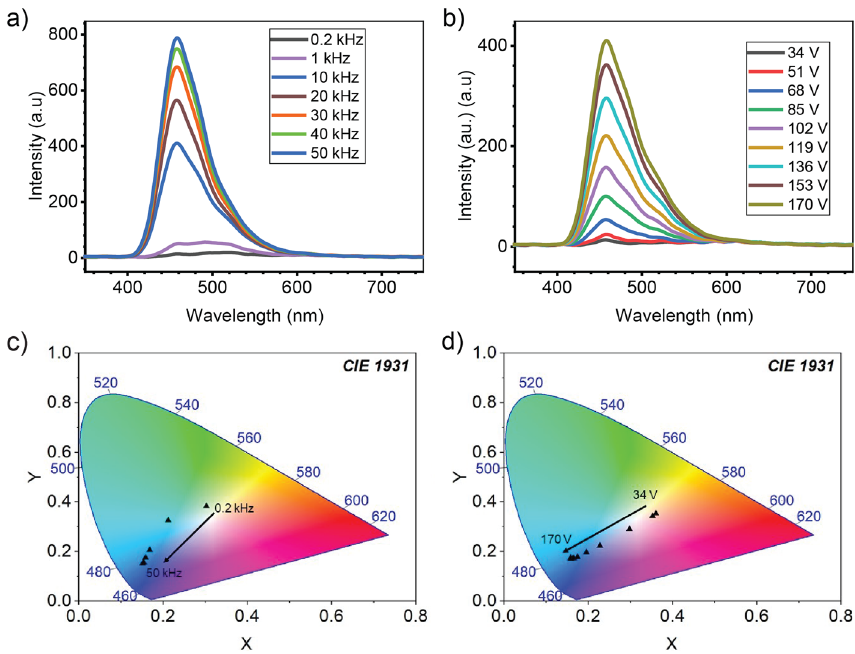
Figure 6. Emission spectrums of the EL devices as functions of ( a ) applied frequency, ( b ) applied voltage. CIE 1931 color space chromaticity diagrams of EL devices by changing ( c ) applied frequency, ( d ) applied